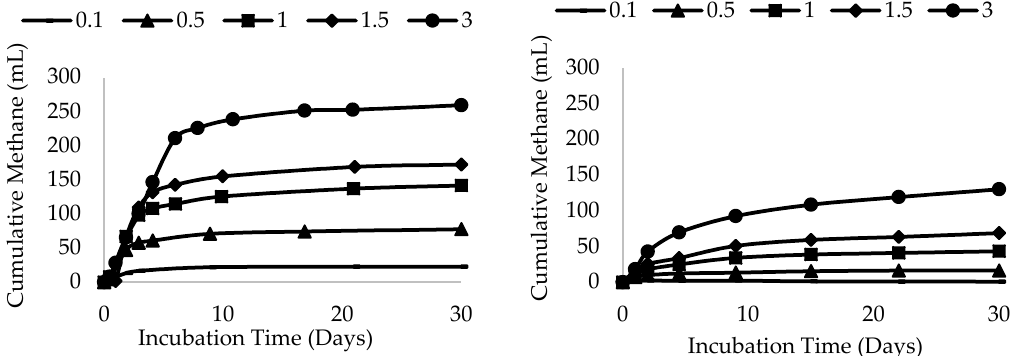
Figure 4. Left : Primary sludge ratio test: cumulative substrate methane production, right : secondary sludge ratio test: cumulative substrate methane production (where 0.1, 0.5, 1, 1.5 and 3 are the g substrate COD/g inoculum VS ratios).